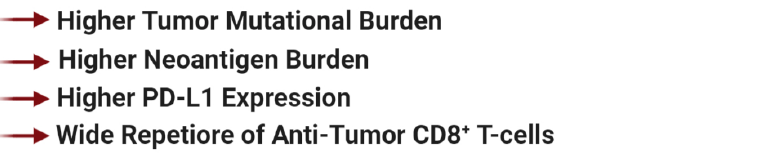
Figure 5. Cutaneous melanoma patients benefit from immune checkpoint blockade therapy better than non-cutaneous melanoma patients. Created with BioRender.com.